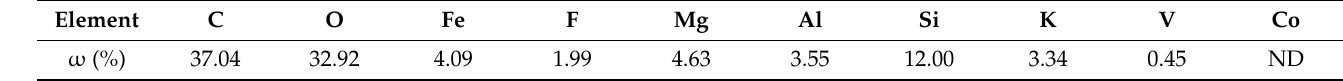
Table 2. Chemical analysis of the raw stone coal.